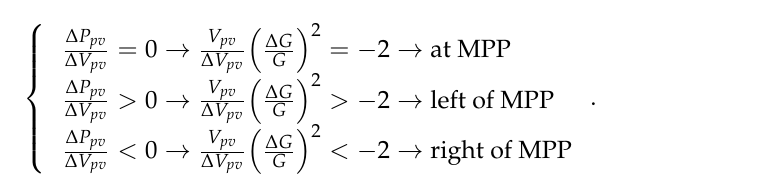
Table 3. Input resistance of the main non-isolated DC-DC converters.